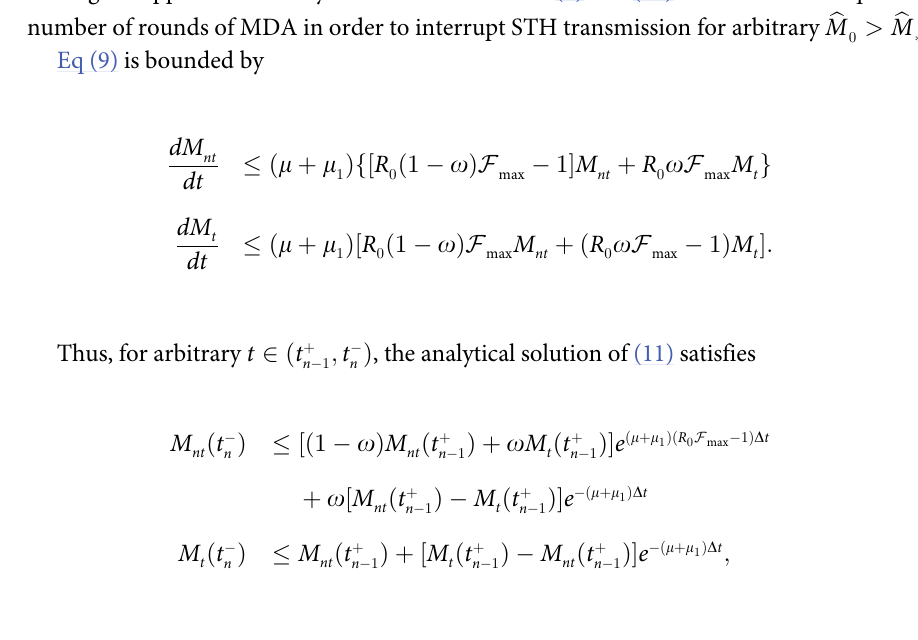
> b M � . (c) b M around the neighbourhood of b M 0 0